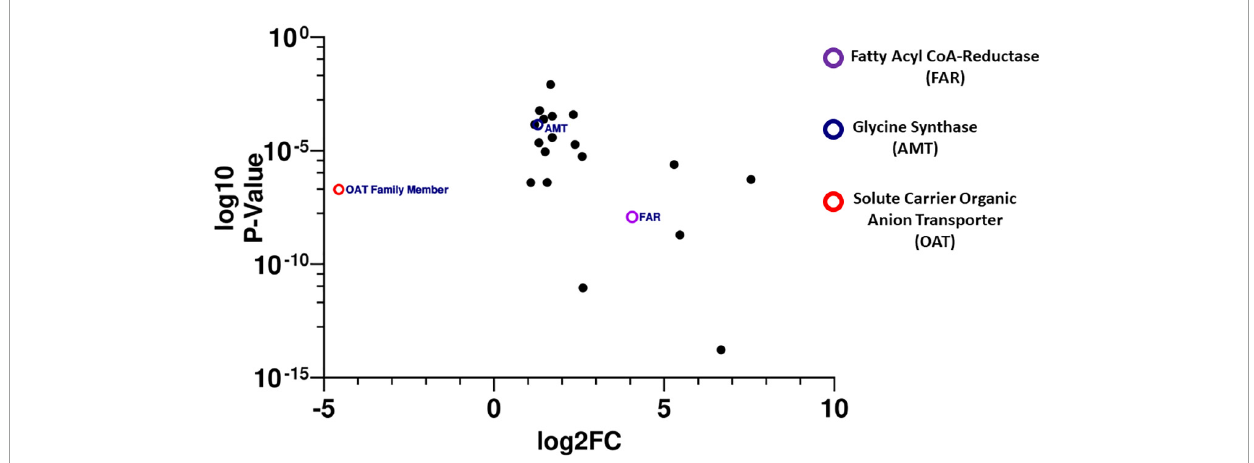
FIGURE4 Plot showing the relative log2 fold change (x-axis) with significance (log10 adjusted p -value; y -axis) of the 21 mRNAs with differential expression between mated and virgin (mated/virgin) bacteriomes of G. morsitans and showing conserved expression patterns between G. morsitans and G. brevipalpis flies. Glycine synthase (AMT), a solute organic anion transporter family member (OAT), and fatty acyl-coA reductase (FAR) are predicted to be regulated by multiple miRNA interactions. The glycine synthase ( amt ) and fatty acyl-CoA genes ( far ) were significantly upregulated